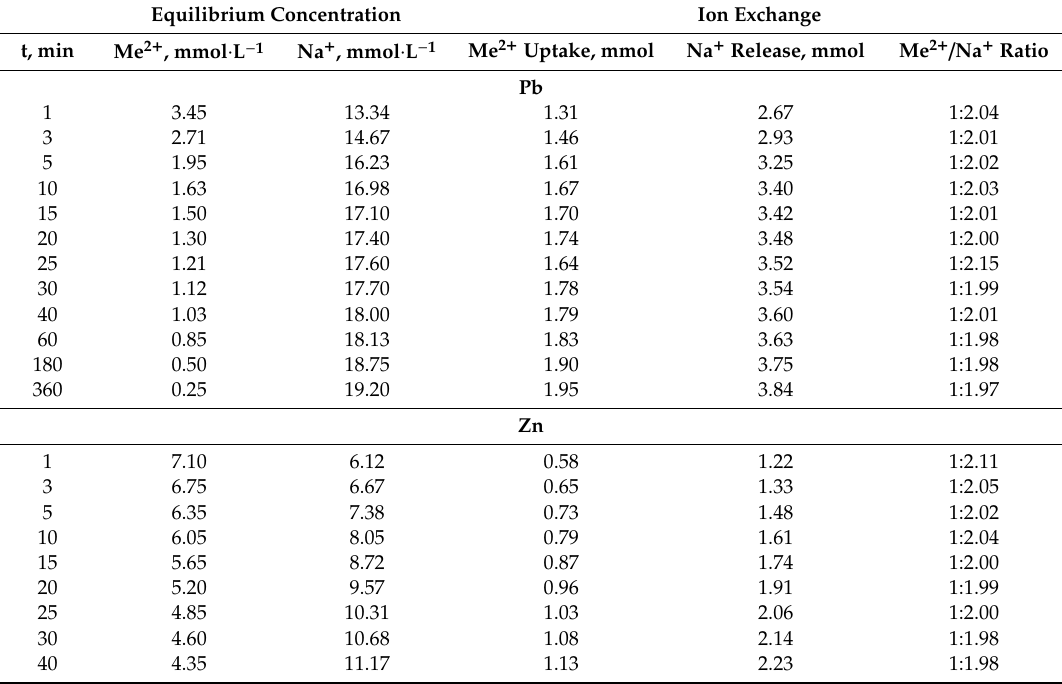
Table 2. Stoichiometry of metal ion exchange on titanium phosphate. The initial concentration of metal ions was 10 mM, with a solid-to-liquid ratio (g:mL) of 1:200.